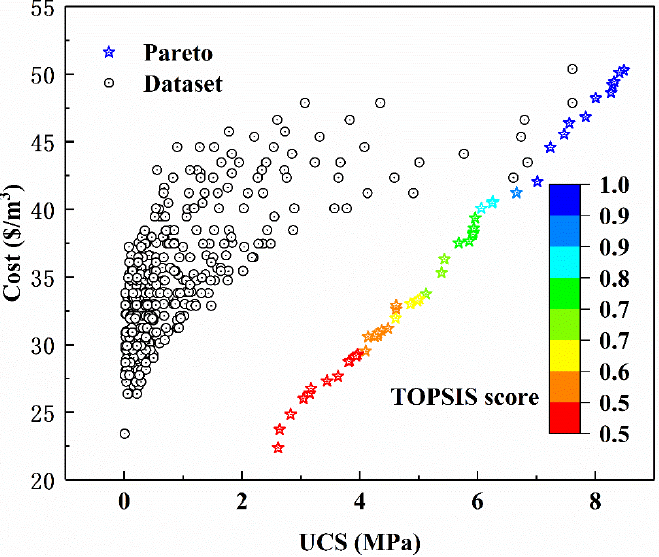
Figure 14. TOPSIS score of the input variable.